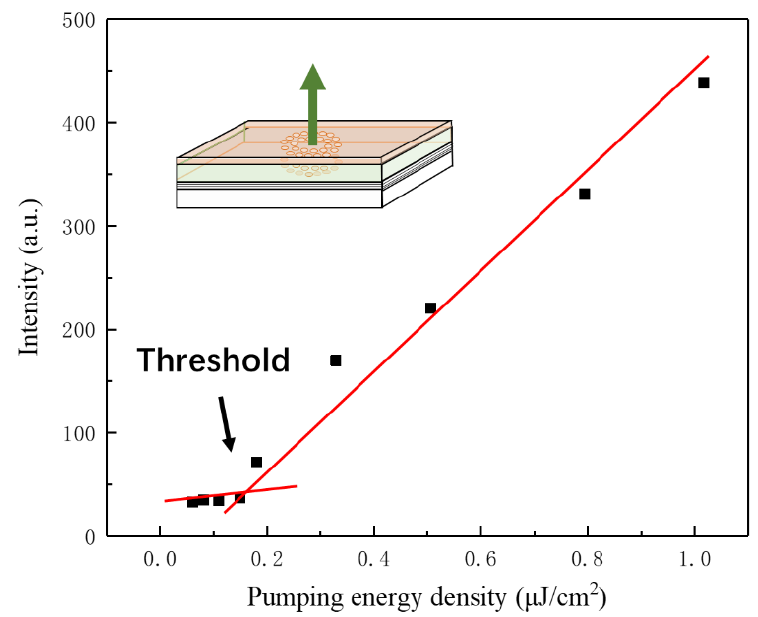
Figure 8. Dependence of lasing intensity on pumping energy density.